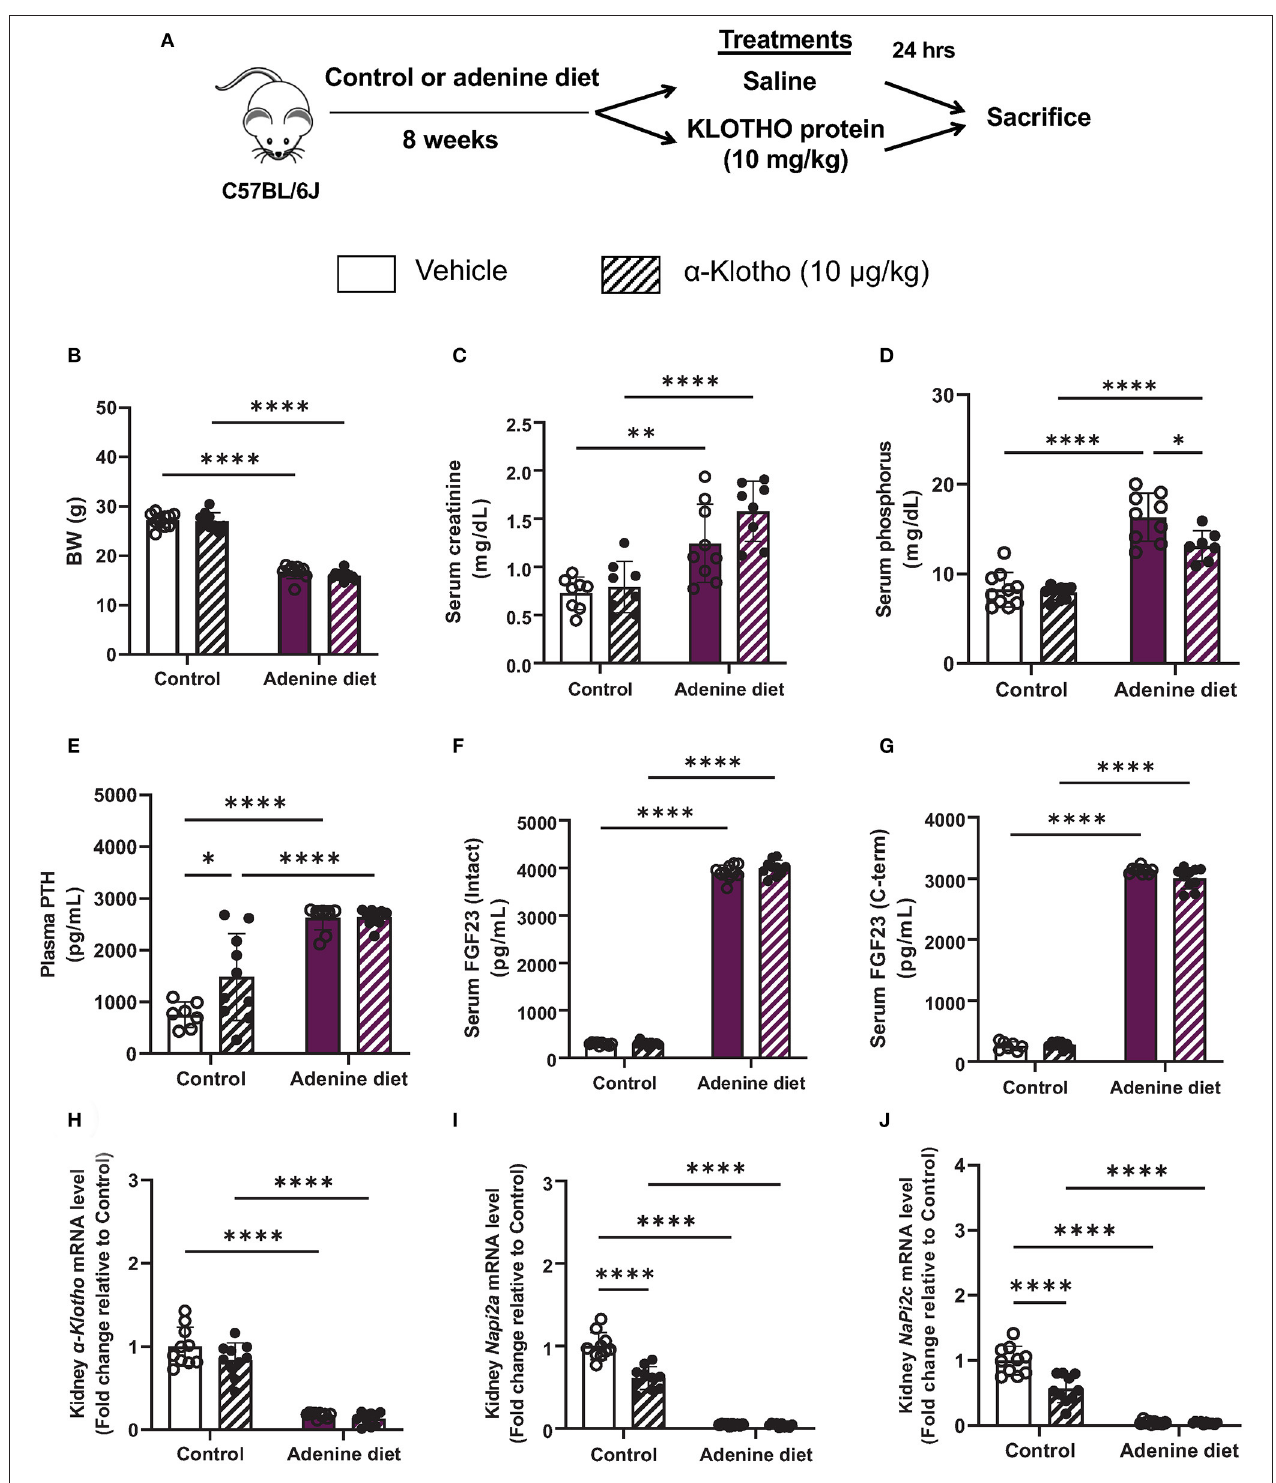
FIGURE 1 | Validation of chronic kidney disease by adenine diet in mice. (A) A schematic of the experimental design. C57BL/6J male mice were fed control or 0.2% adenine diet for 8 weeks. After 8 weeks, mice in each group were further divided into 2 groups and were injected with either saline or mouse recombinant Klotho protein (10 µ g/kg) 24h before sacrifice. (B) Body weight at the end of experiment. (C,D) Serum concentration of (C) creatinine and (D) phosphorus. (E) Plasma PTH levels measured by ELISA. (F) Intact and (G) C-terminal FGF23 levels in serum measured by ELISA. (H–J) Quantitative real-time RT-PCR for renal (H) α - Klotho , (I) Napi2a , and (J) Napi2c expression. Data are expressed as fold change (2 − 11 Ct ) relative to housekeeping gene Hprt . Samples were measured in duplicates. Data are represented as mean ± SD. ( n = 7–10 per group). * P < 0.05, ** P < 0.01, **** P < 0.0001 compared to Control.